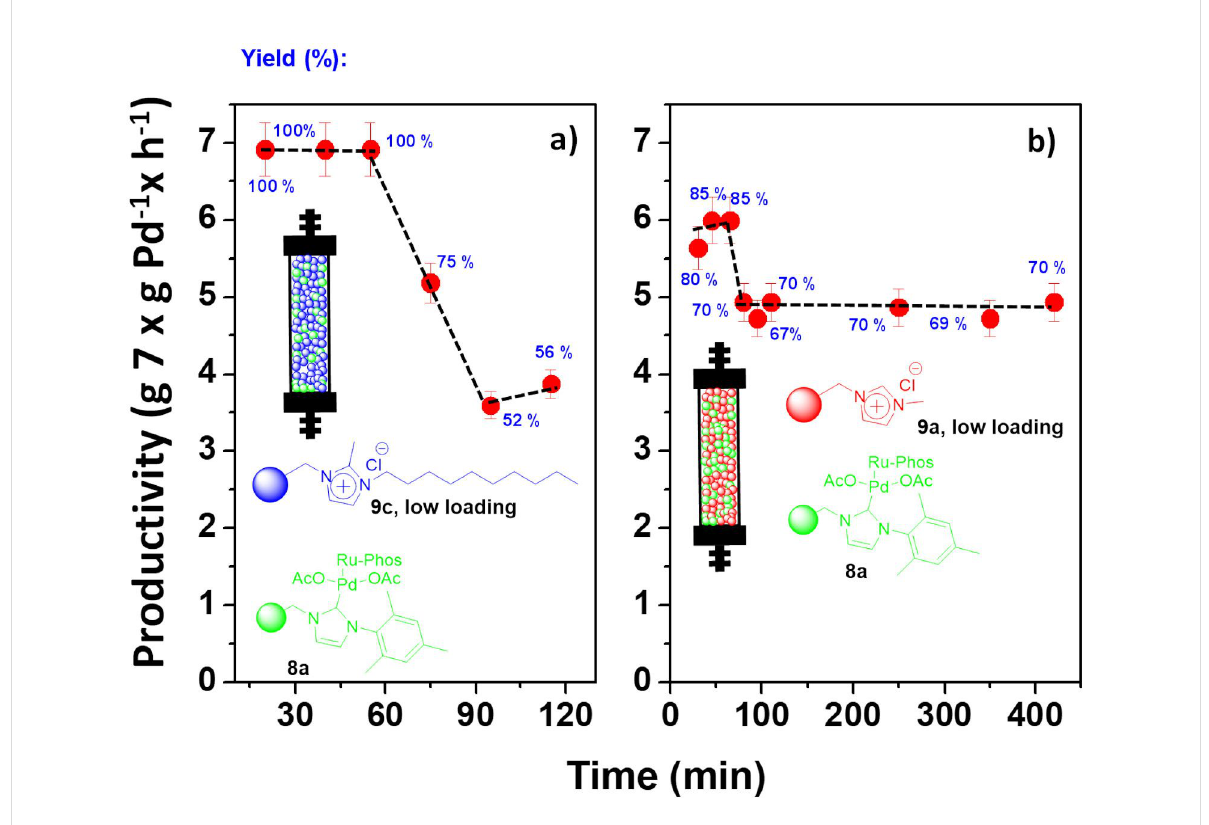
Figure 8: Effect of the structure of the SILLP scavenger for the Negishi reaction between 5 and 6 under flow conditions catalyzed by 8a in the pres- ence of SILLPs 9a or 9c . 60 °C. Total flow rate: 0.1 mL/min. 0.05 mL of a 0.2 M solution of 5 in THF and 0.05 mL/min of a 0.1 M solution of 6 in THF. V = 1.7 mL, residence time = 17 min. Productivity max: 7.08 g 7 × g Pd − 1 × h − 1 . a) 250 mg of 8a and 750 mg of 9c SILLP low loading, b) 250 mg of 8a and 750 mg of 9a SILLP low loading. Yield calculated by GC and confirmed by 1 H